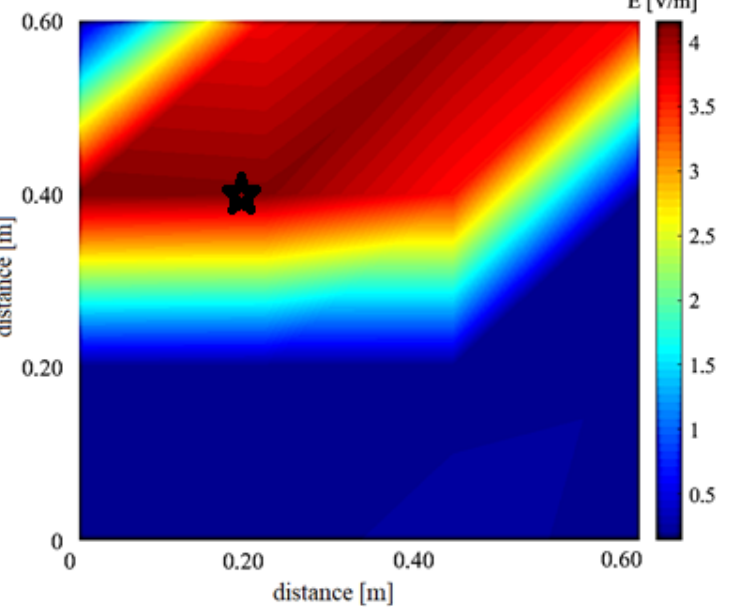
Figure 10. Experimental results: electric field strength spectrum in region of interest during one person on the phone: f = 1744 MHz. Table 2. Maximum values of electric field strength measured in head phantom for frequency band 1700–1800 MHz.